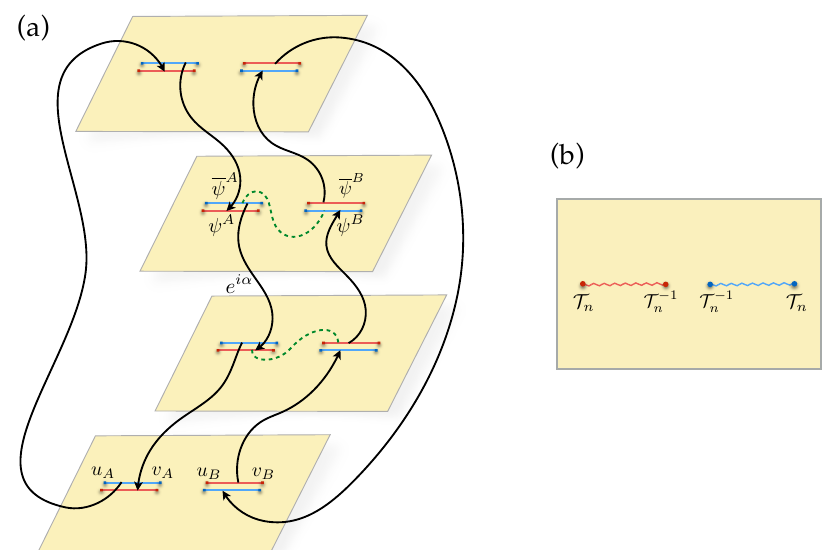
( α ) , Eq. (53), for n = 4. The N n